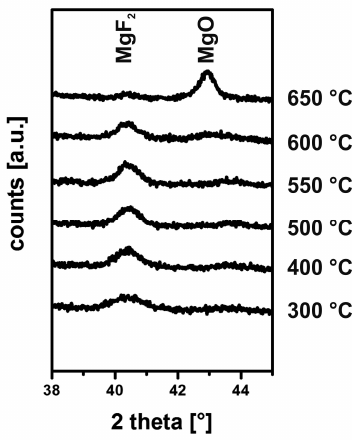
Figure 11. XRD pattern of MgF 2 films on borosilicate glass. Reproduced with permission from [42]. Copyright The Royal Society of Chemistry, 2012.